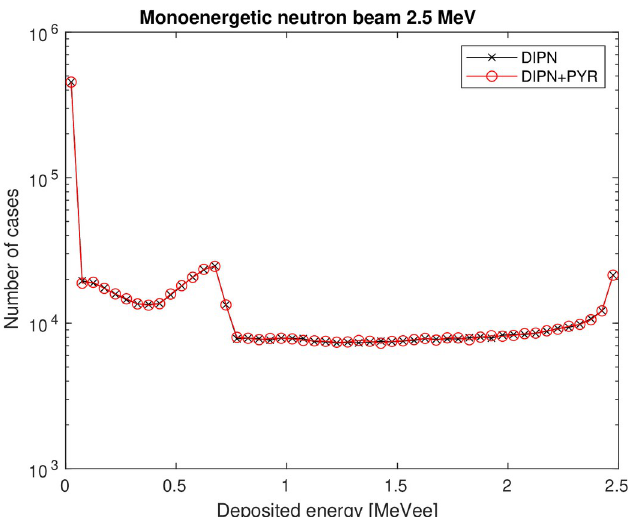
Fig 5: Response of scintillator with PYR luminophore to neutrons of energy 2.5 MeV.